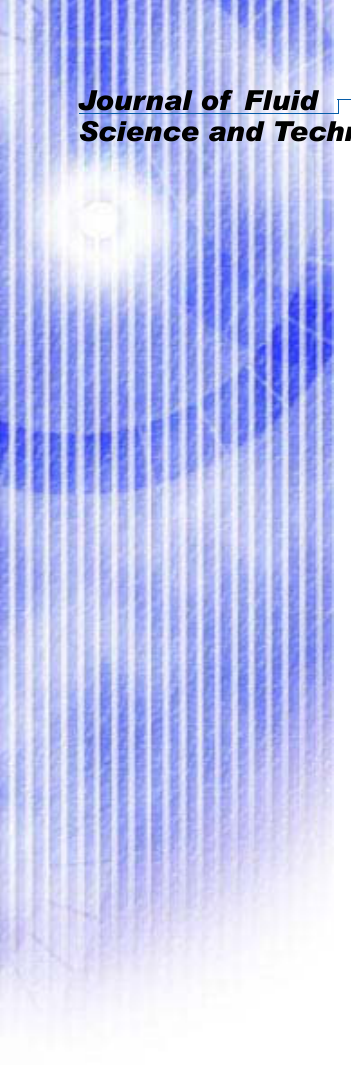
Fig.5 Instantaneous contours of the cell